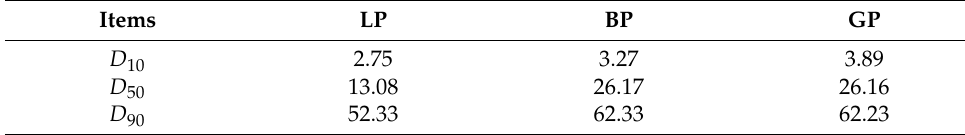
Table 3. Particle size distributions of three mineral